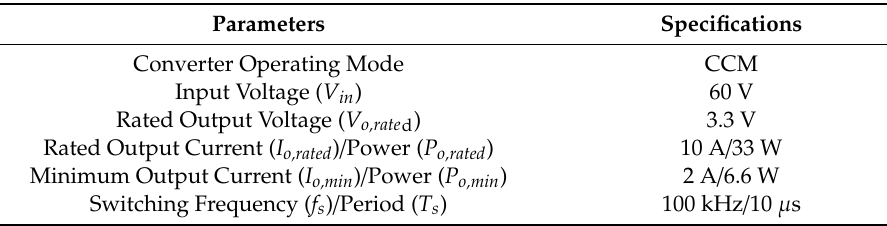
Table 2. System specifications